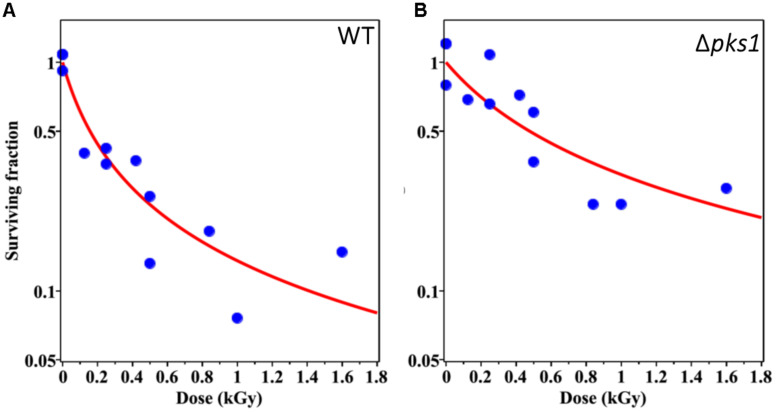
Survival of WT (A) and Δpks1
(B) cells after irradiation with ionizing particles of different LET. Blue circles represent experimentally determined data points from the survival assay and red lines indicate the most optimal (best-fit) survival curve for each strain, using maximum likelihood, when incorporating CFU data at each dose into the survival function (Eq. 3). Dose in kGy is provided on the x-axis.